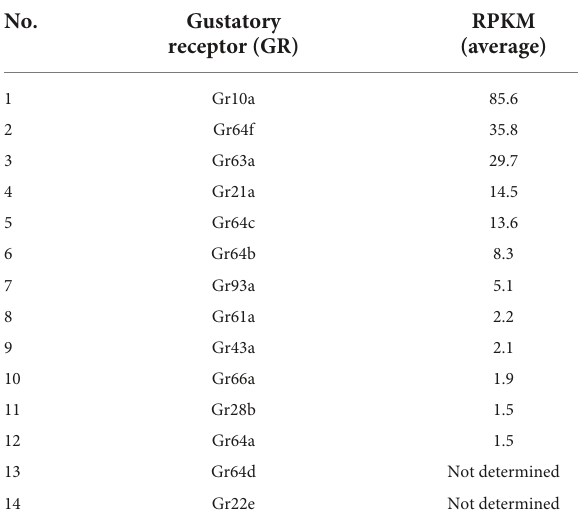
TABLE 3 A list of 14 GRs identified in the antenna based on previous studies (Dunipace et al., 2001; Menuz et al., 2014).